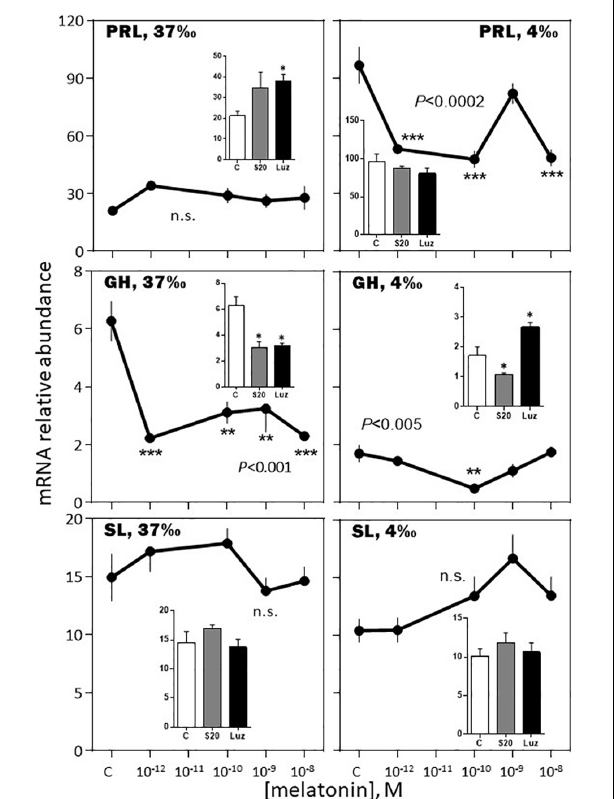
FIGURE 6 | Effects of melatonin and melatonin analogs on PRL, GH and SL mRNA relative abundance in vitro . The experiment was performed in February. The BW fish were acclimated to either seawater (37 ; left column) or freshwater (4 ; right column) 3 weeks before sacrifice. The pituitaries were (cid:104) challenged for 12 h with the different concentrations of melatonin indicated in (cid:104) the abscissae (see Materials and Methods section for details). The controls (C in the abscissae) received an equivalent amount of solvent present at the highest melatonin concentration; it did not exceed 0.0001% in the final solution. Mean ± S.E.M. of n = 3 pools (containing 5 glands each). One-Way ANOVA ( P gives the level of significance; n.s.: non-significant). Means were compared to the corresponding control using the Holm-Sidak’s post hoc test: * P < 0.05, ** P < 0.005, *** P < 0.0005. The insets show the 12 h effects of two melatonin analogs S20304 (S20 at 10 – 8 M) and luzindole (Luz at 10 – 7 M). Mean ± S.E.M. of n = 3 pools (containing 5 glands each). Values are compared to the controls using the Student’s t -test at Significant ∗ P <